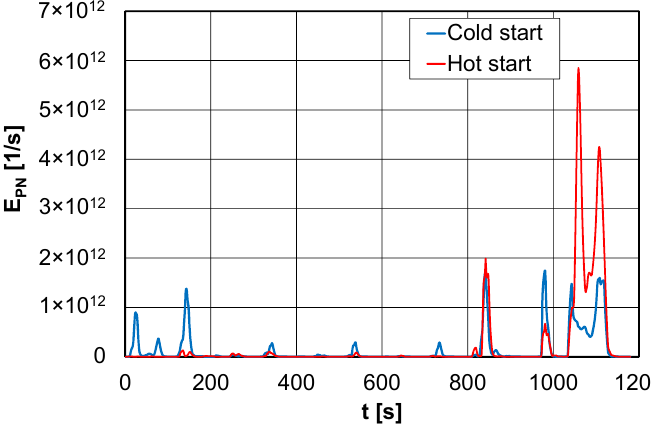
NOx ) for cold and hot engine start.